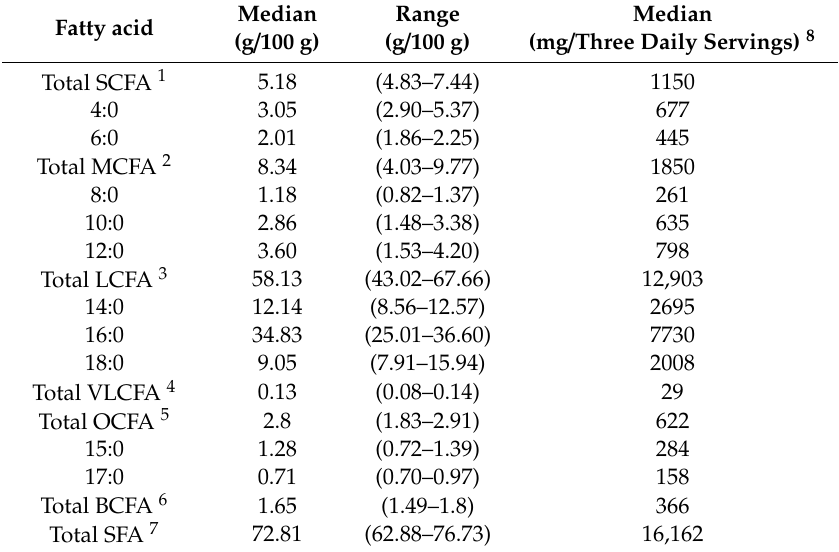
Table 1. Typical composition (g / 100 g) and content (mg / three daily servings) of key saturated fatty acids in bovine-derived milk. Fatty acids are median values in milk, pre-averaged by breed at four di ff erent timepoints across a lactation